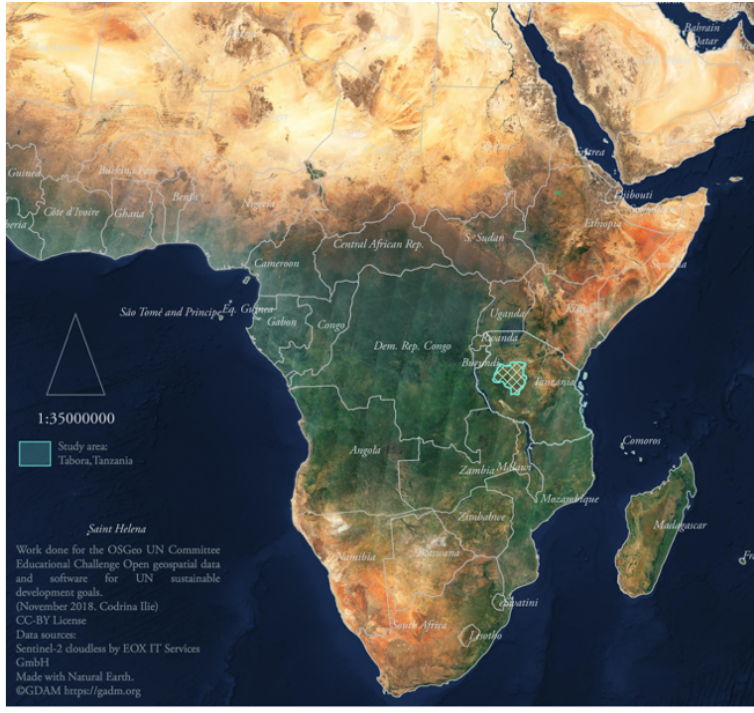
Figure 1. Tabora region in